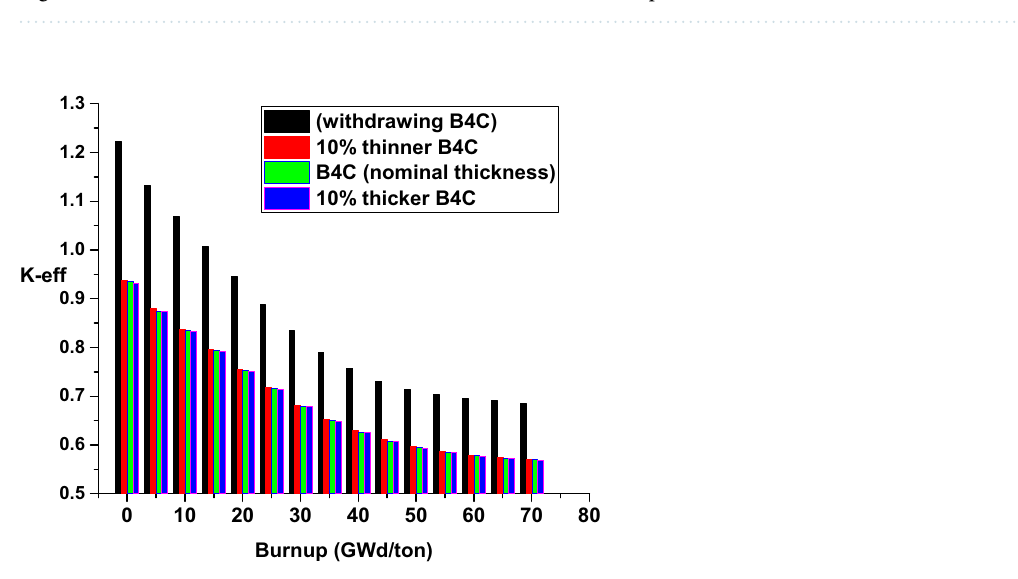
Figure 20. K-effective results with burnup for the four